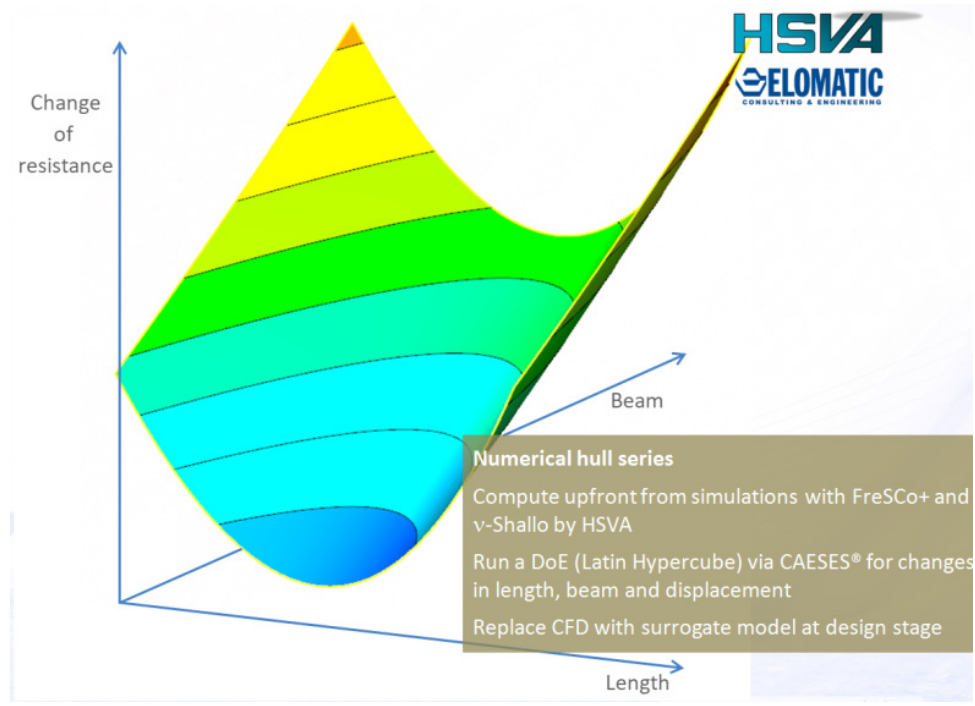
Figure 10. Surrogate model for DE-ferry